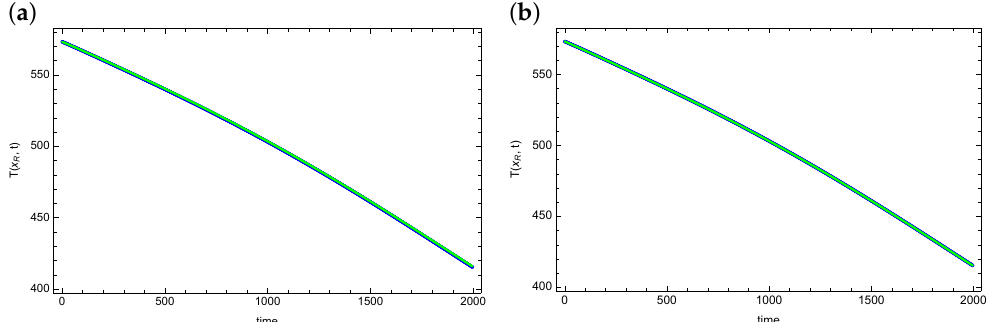
Figure 4. The exact temperature T ( x R , t ) in measurement point (blue line) and reconstructed temper- ature (green line) for ( a ) ACO and ( b ) DBOA.